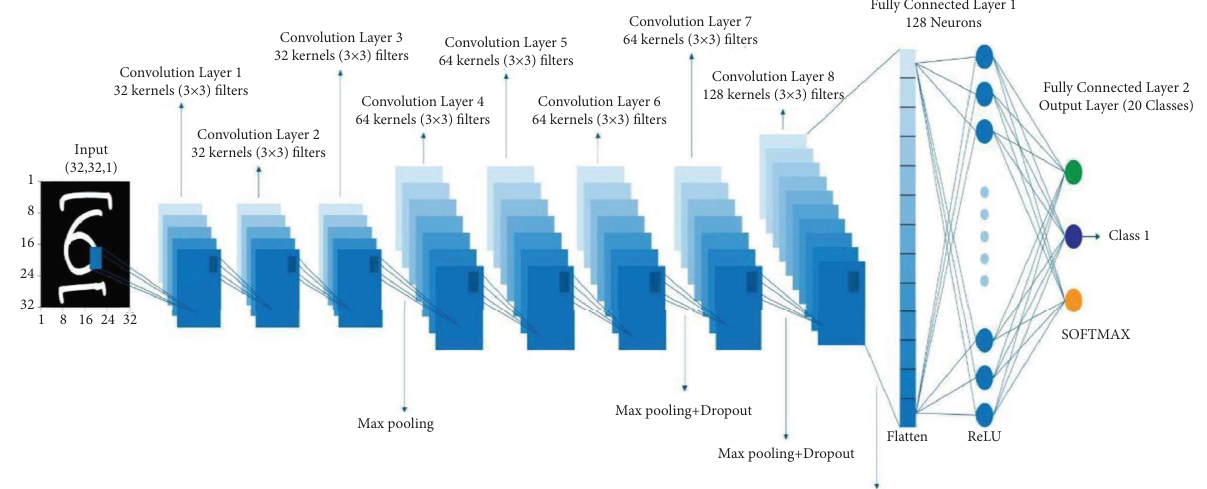
Figure 5: Te convolutional neural network architecture of the proposed system.